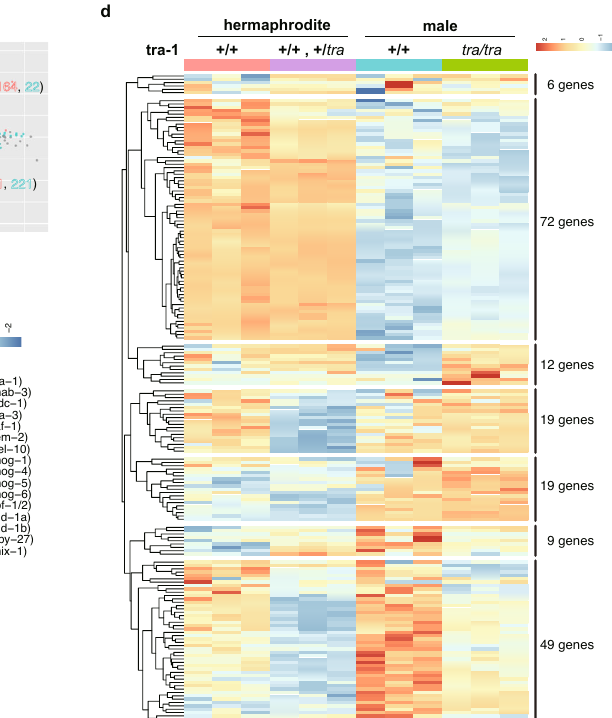
genes (111 genes) and masculine genes (92 genes) were down- regulated, but genes with high-fold changes (fold-change >4) were dominated by feminine genes (66/103 genes).